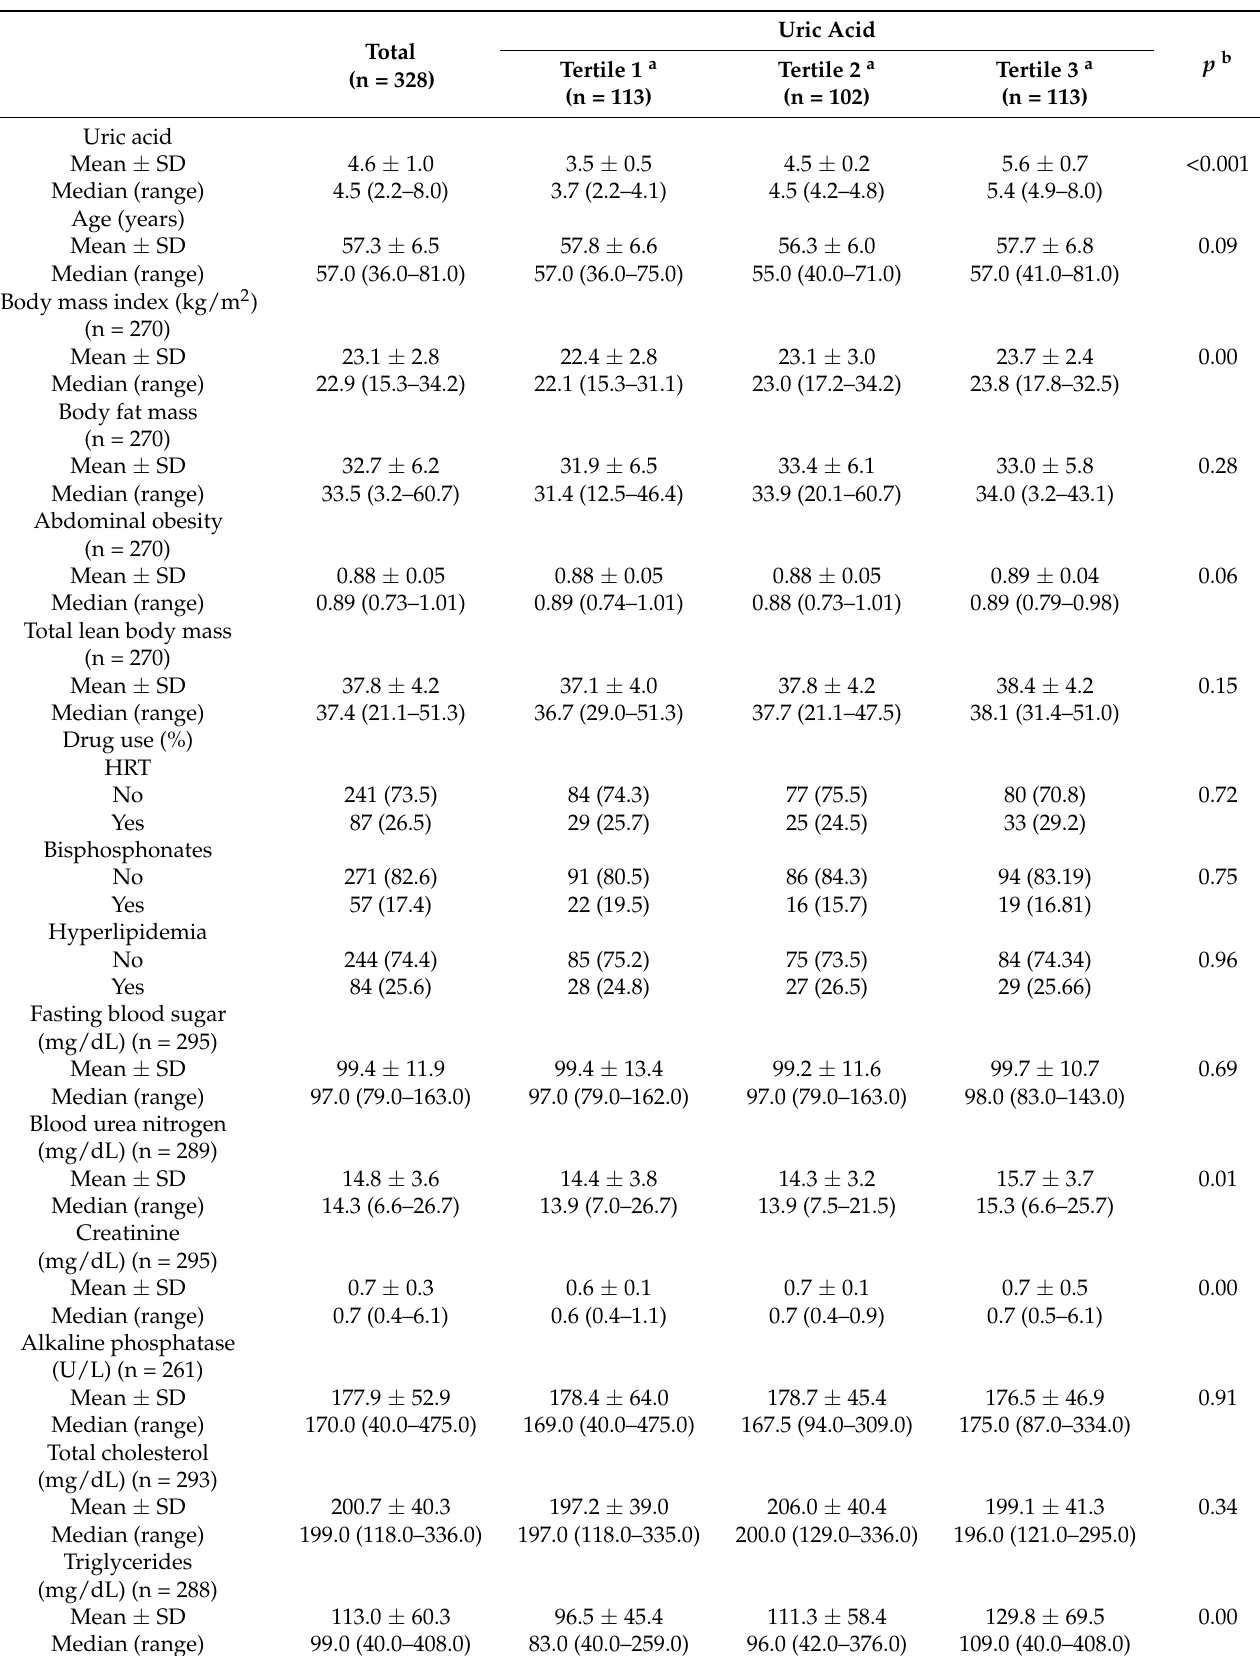
Table 1. Baseline characteristics of the